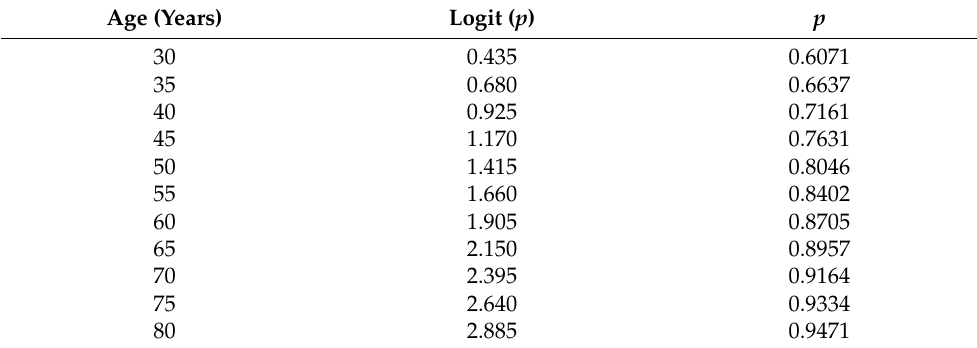
Table 5. The risk of mortality in a dialysis male patient.